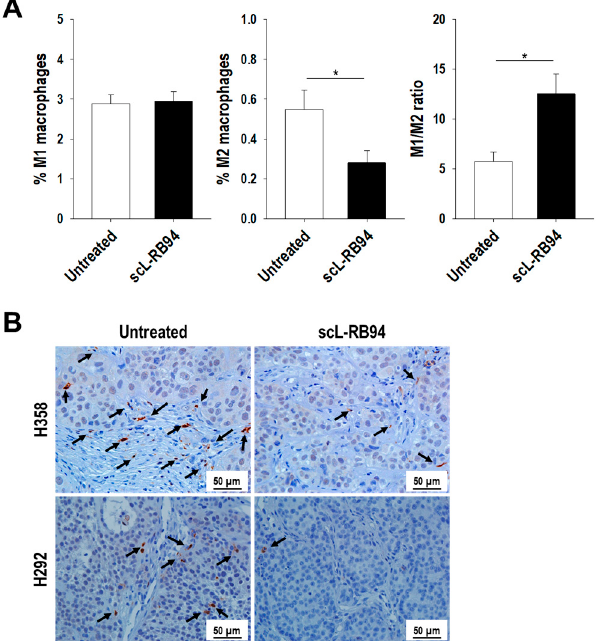
Figure 5. scL-RB94 reduces immunosuppressive M2 macrophages. Athymic mice bearing either H358 or H292 tumors were treated with scL-RB94 (30 μ g/injection/mouse, two injections over 3 days). Forty-eight hours later, harvested tumors were processed for flow cytometry or IHC analyses ( N = 8). ( A ) Macrophages infiltrating H358 tumors were identified by flow cytometry using gates for M1 macrophages (CD11b+F4/80+CD86+) and M2 macrophages (CD11b+F4/80+CD206+) in CD45 + live cells. * p < 0.05, Student’s t test. ( B ) Representative staining for Arg-1, a common marker for M2 macrophages in H358 and H292 tumors. Arrows indicate Arg-1 positive cells.